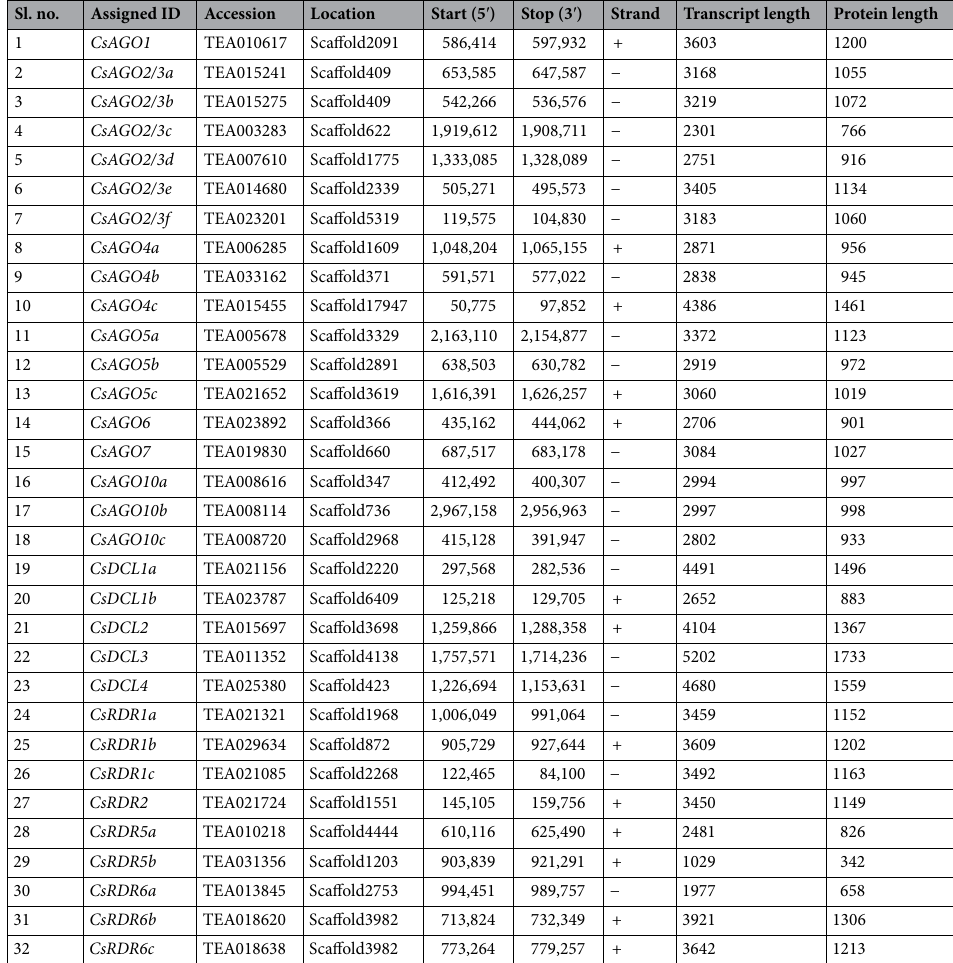
Table 1. Properties of identified CsAGO , CsDCL and CsRDR